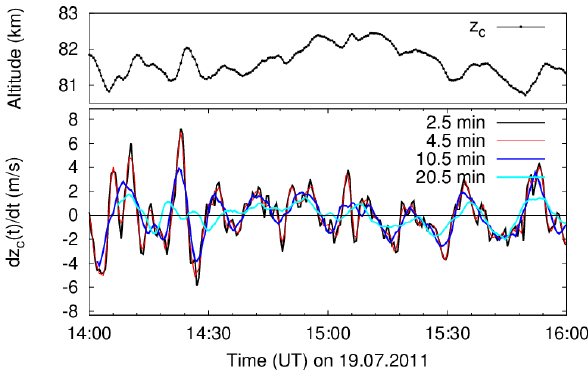
Fig. 5. Top: section of the time series z c (t) on 19 July 2011 (SET). Bottom: derivatives using different time